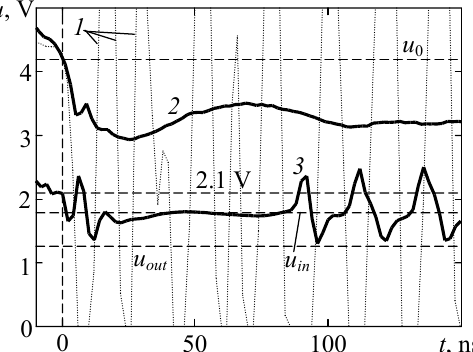
Fig. 4. Voltage on the Gunn diode 3A702: at the inductance of the measuring circuit of 230 nH ( 1 ) and 30 nH ( 2 and 3 ). (For curve 2 , the average voltage is more than 2.1 V and for curve 3 , it is less than 2.1